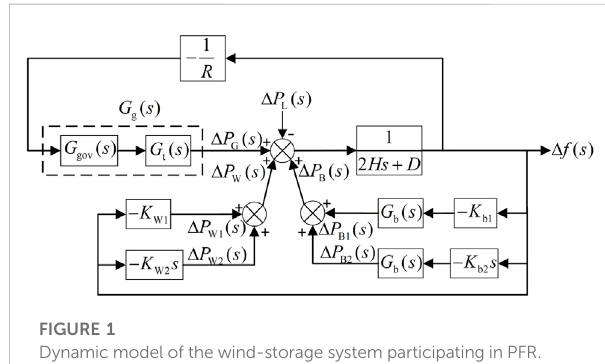
FIGURE 1 Dynamic model of the wind-storage system participating in PFR.